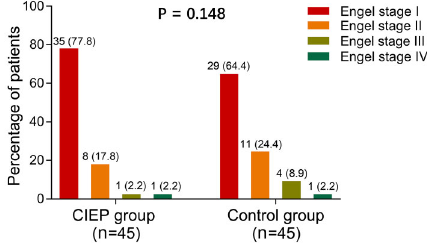
Figure 5. Engel classes and percentages of the caregiver intensive education program (CIEP) group and the control group at month 6. P o 0.05 was considered statistically signi fi cant by the Wilcoxon rank sum